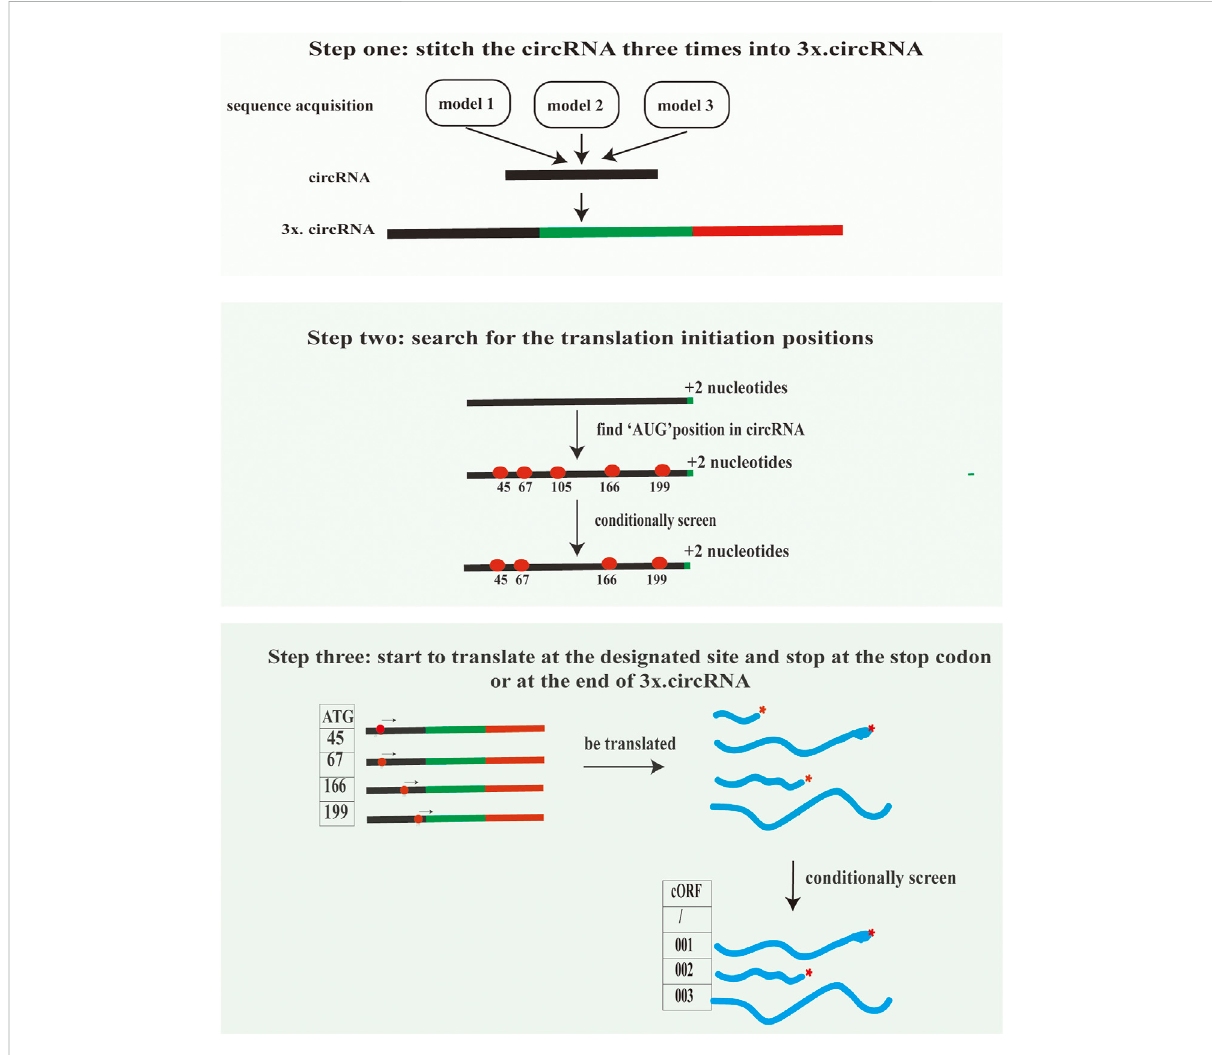
Algorithm used to identify all possible cORFs in each circRNA. Models 1 to 3 show three approaches for obtaining the exon nucleotide sequencesofcircRNAstopredictcORFs.Instep1,thesequencesofcircRNAarerepeatedthreetimessothatthecORFsincircRNAscanbepredicted completely, except for those cORFs rolling the circle more than three times. In step 2, “ +2 nucleotides ” in the 3 ’ end of the sequence can avoid missing start codons located atBSJs (e.g., “ A ^ TG ” and “ AT ^ G ” )when searching for possible startcodonsin circRNA sequences.Inthe fi nal step,all the possible cORFs are